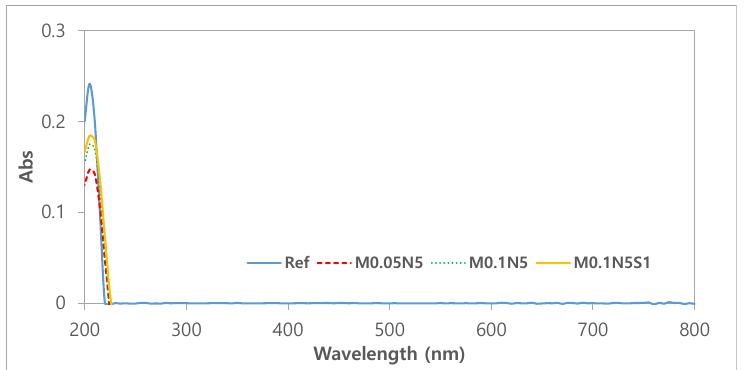
8 of 13 Figure 6. Tensile strength image of ( a ) Ref sample, ( b ) M0.05N5 sample, ( c ) M0.1N5 sample, and ( d ) M0.1N5S1 sample.